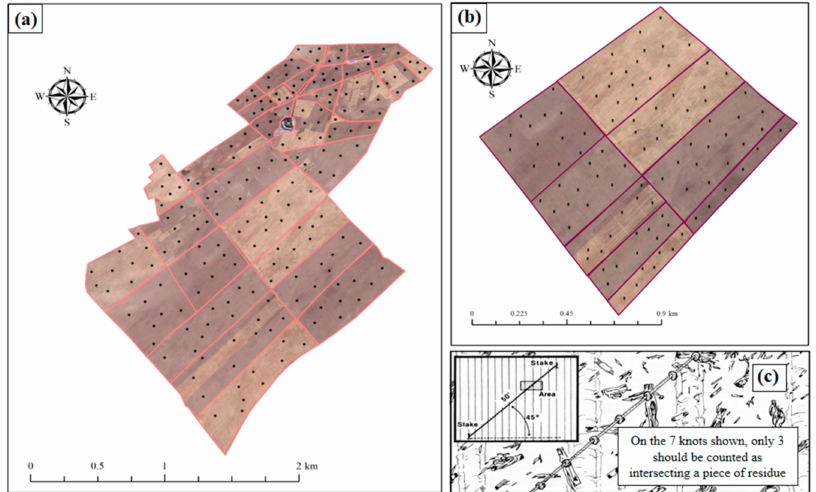
Figure 4. ( a ) Distribution of line-transect sampling locations over the study area under Sentinel-2 satellite imagery, ( b ) Distribution of line transect sampling locations over the study area under UAV imagery, and ( c ) a close-up of the line-transect method